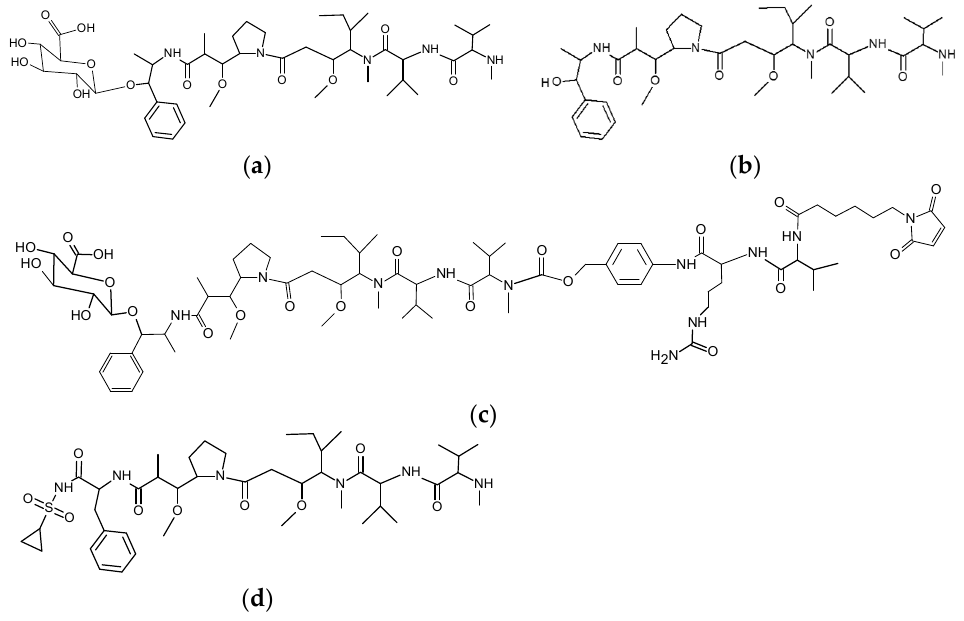
Figure 1. Structures of the payloads and linkers in the present study. ( a ) MMAU, β- D -glucuronyl- monomethylauristatin E; ( b ) MMAE, monomethylauristatin E; ( c ) MC-Val-Cit-PABC-MMAU, ε- maleimidocaproyl- L -valine- L -citrulline-paraaminobenzyloxycarbonyl-MMAU; ( d ) Duostatin 3. Hydrophilic and lysosomally cleavable glycoside payload MMAU allows for generation of homogeneous drug-to-antibody ratio (DAR) = 8 antibody-drug conjugates (ADCs) with high efficacy, safety to non-target cells and utilization of the bystander effect.